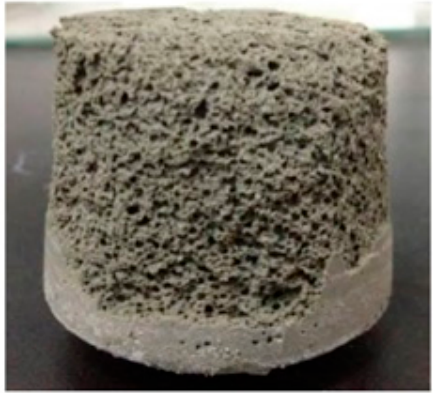
Figure 11. The pores in backfilling body.